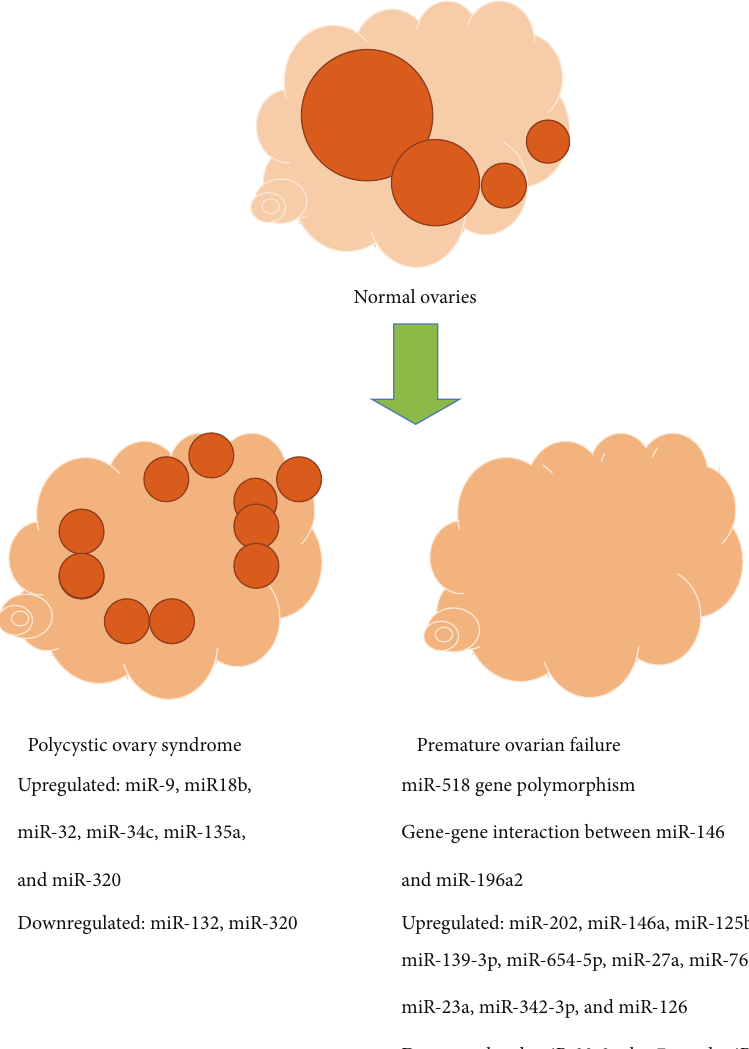
Figure 3: MiRNAs that were differently expressed in follicular fluid and plasma of women with polycystic ovary syndrome [51–54] and premature ovarian failure [55–60] in comparison to healthy women with normal